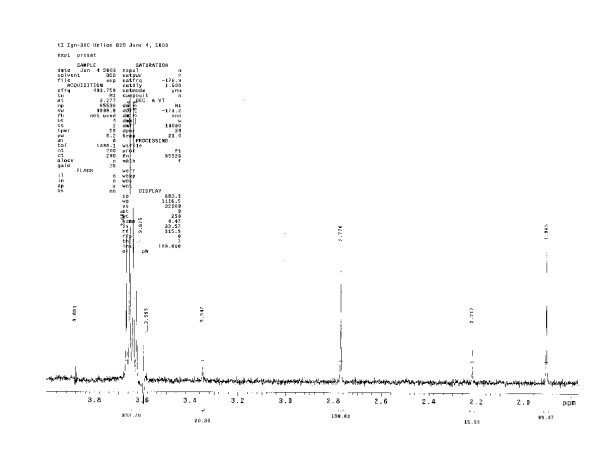
1H-NMR Spectrum of Ignatia-30 C (Helios): expansion of 1.8 – 4.0 ppm region. Key to peaks [position – interpretation]: 1.90 – acetate; 2.22 – acetone; 2.77 – C6H8O2 (1,4-cyclohexanedione marker); 3.35 – methanol; 3.60 – artifact (C1); 3.65 – ethanol, methylene quartet; 3.88 – artifact (R5).